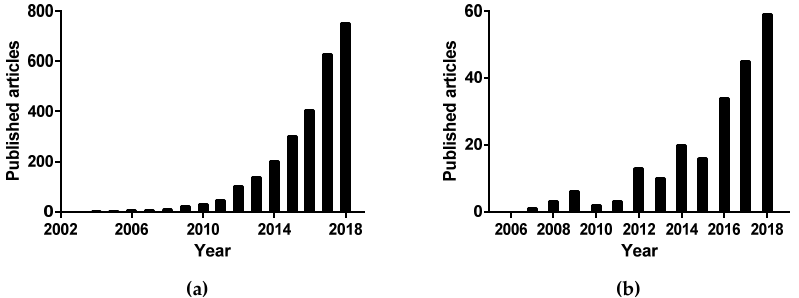
Figure 1. Number of published articles per year on ( a ) deep eutectic solvents and ( b ) deep eutectic solvents and polymers. Data from Web of Knowledge [18].